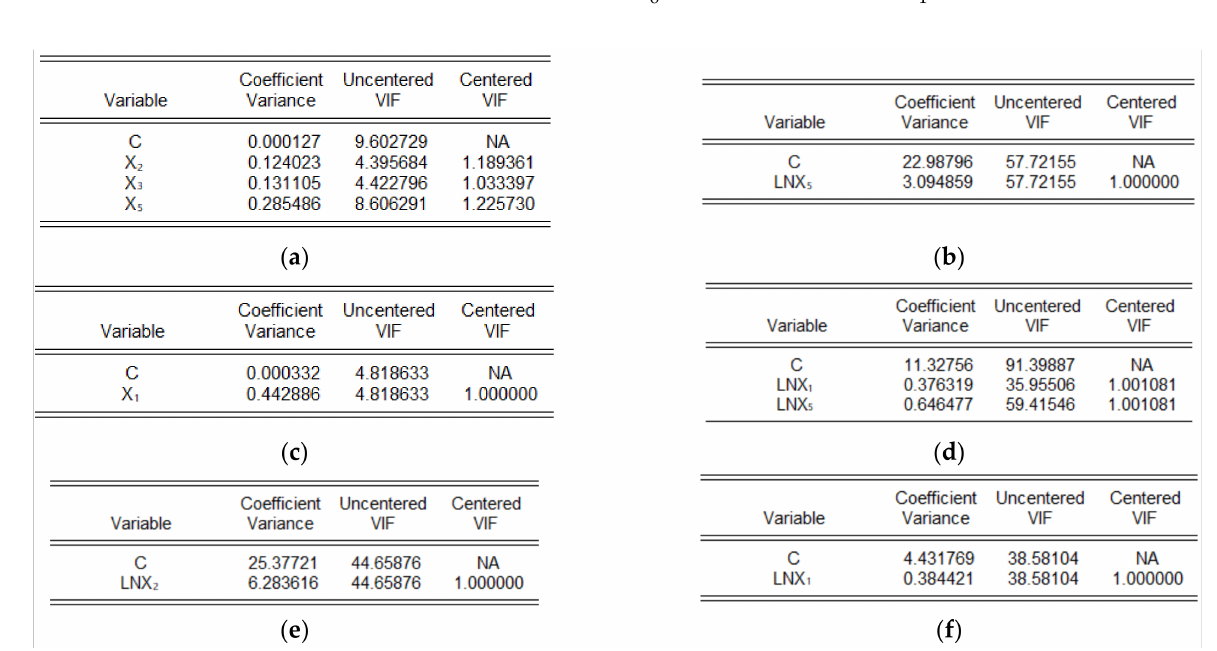
Figure 7. VIF test results of Models. ( a ) VIF test results of Model 7; ( b ) VIF test results of Model 8; ( c ) VIF test results of Model 9; ( d ) VIF test results of Model 10; ( e ) VIF test results of Model 11; ( f ) VIF test results of Model 12.